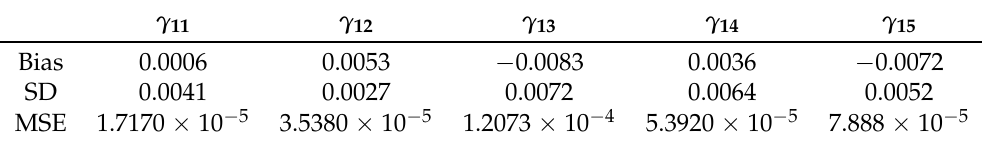
Table 9. Bias, SD and MSE evolutions with respect to the parameter γ variation for GNFPLSIM with the identity link function and n = 500.